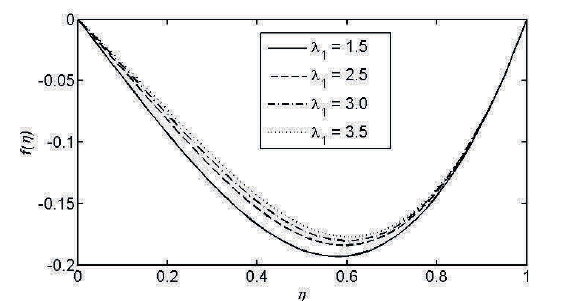
Fig. 2: Variation of f ( η ) for different values of λ 1 for λ 2 = 1, M =